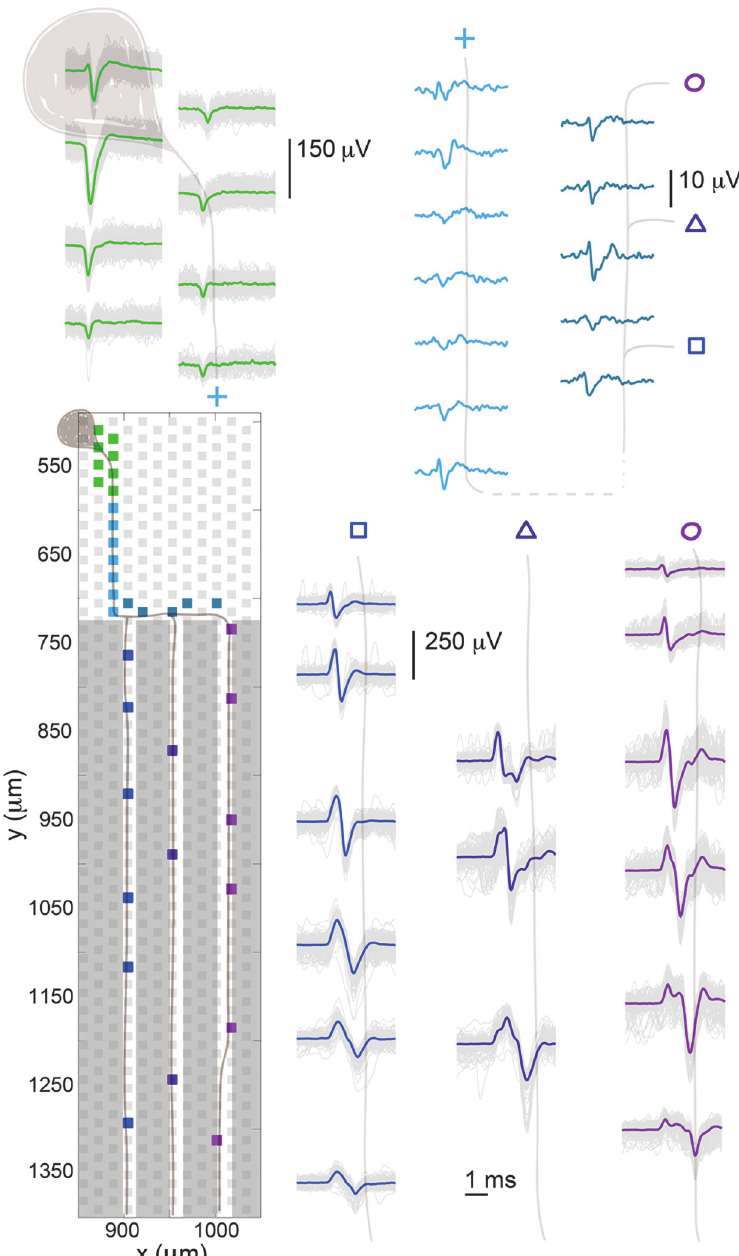
Fig 5. Spontaneous spike propagation from a soma to a branched axon. Spike-triggered averaging of the large green somatic spike revealed a branching axon, which grew into three channels. The footprint of the soma was spread across several electrodes and showed the typical somatic shape: essentially monophasic, negative spike. The small axonal signal outside of the channels is shown in blue. Electrodes in three adjacent channels recorded spikes that were time aligned with that of the soma, and their positions and spike shapes are shown. The spike amplitudes were very different for the different cellular components (soma, axon outside channels, axon inside channels) as indicated by the scale bars. A cartoon neuron was drawn over the traces to guide the